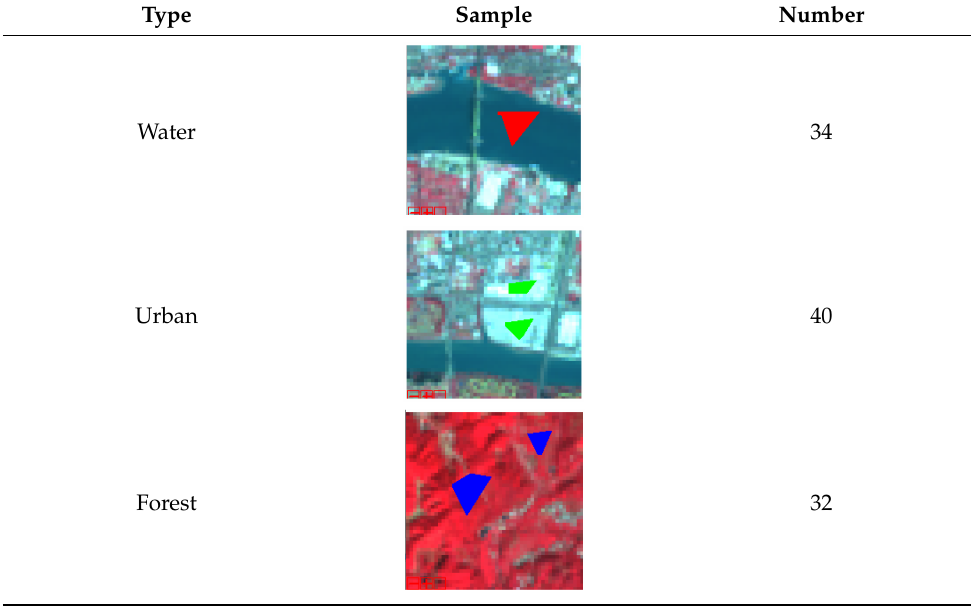
Table 2. Selection of samples for training set in